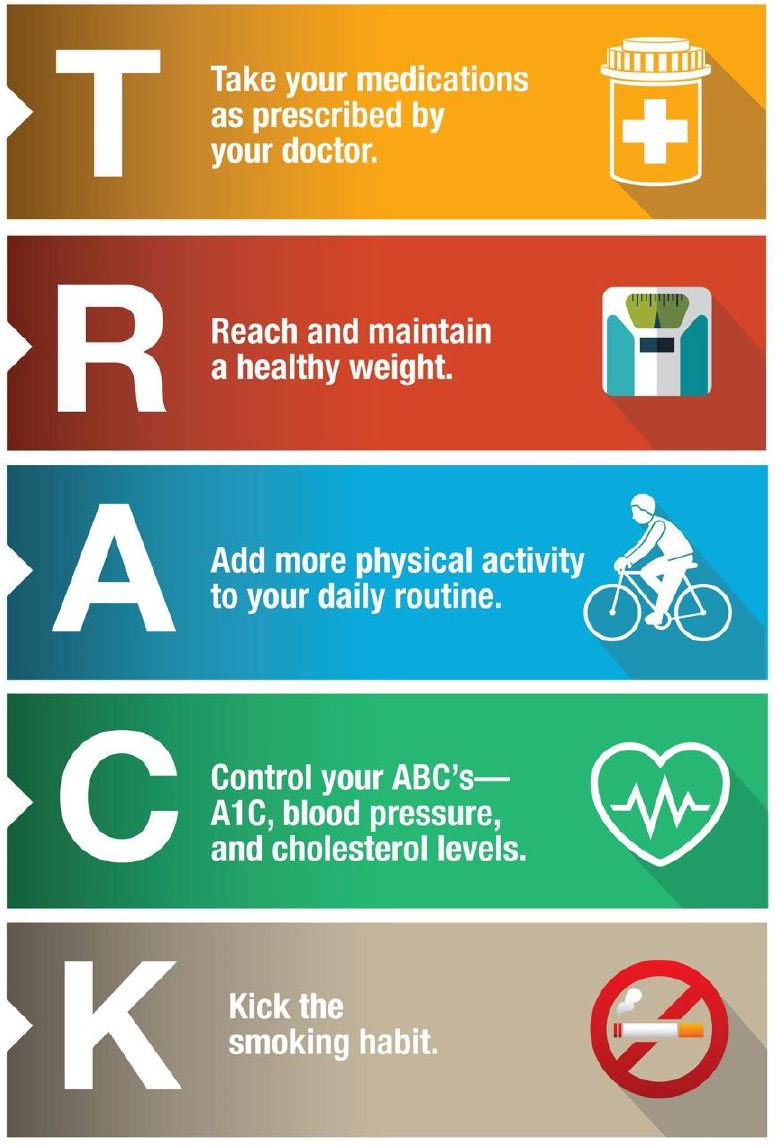
Figure 1. TRACK, a program of National Institute of Health (NIH), England to memorize the factors that can contribute to health while living with diabetes